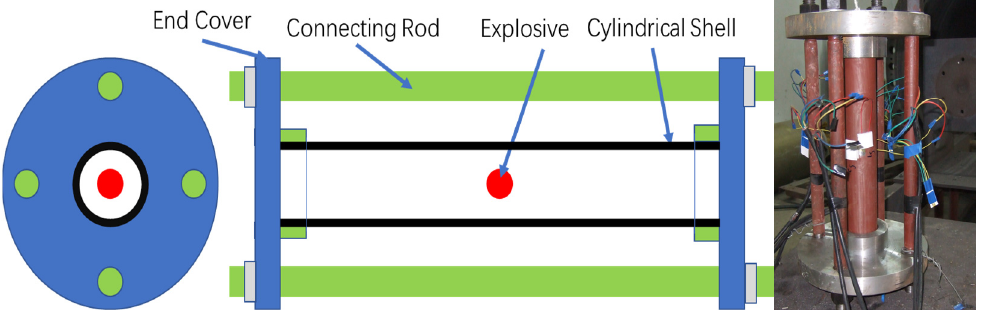
Figure 1. The cylindrical shell experiment structure.